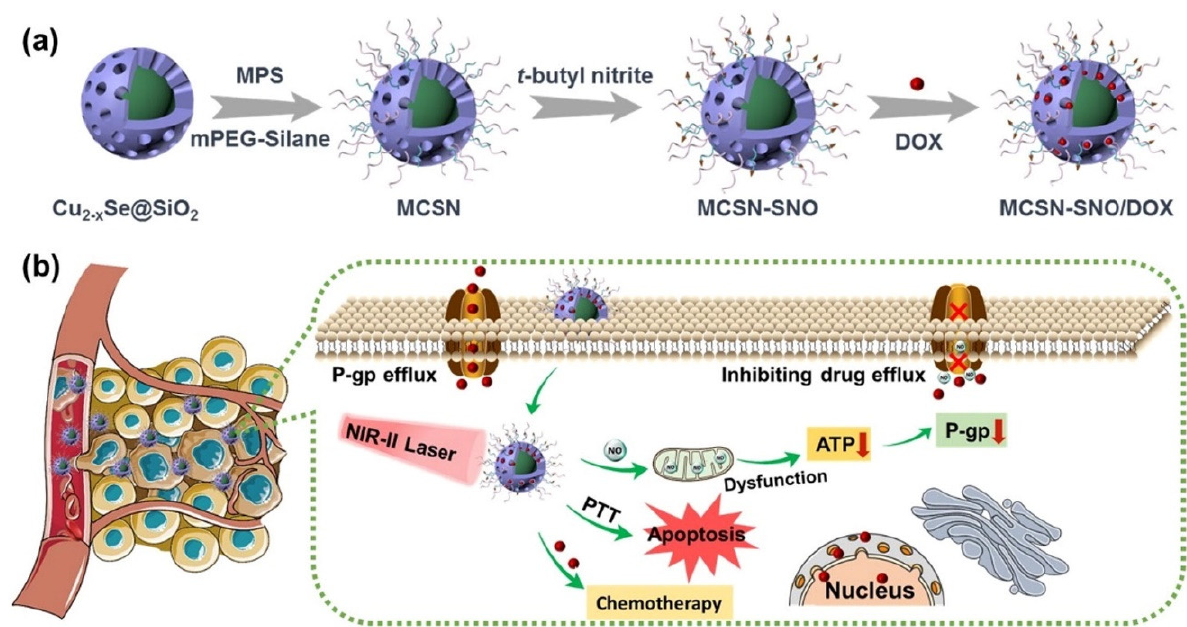
Figure 14. Schematic illustration of ( a ) the synthetic procedure of MCSN-SNO/DOX and ( b ) the process of photothermal-responsive NO gas release for overcoming multidrug resistant tumor by combination therapy (Reprinted with permission from Ref. [198]. 2021, Youyou Huang).